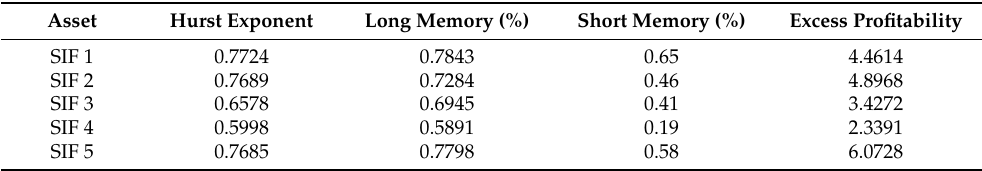
Table 1. Index values according to Hurst exponent, Fractal Dimension, and Generalized efficiency measure for the period 2005–2019.